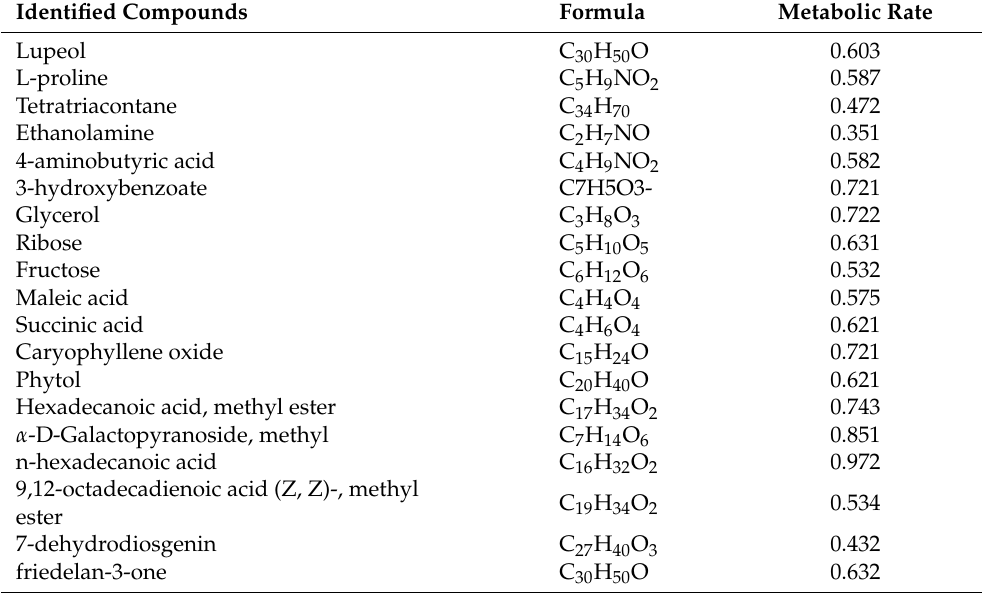
Table 8. Compounds identified through GC–MS of P. lonchitis whole plant and their metabolic